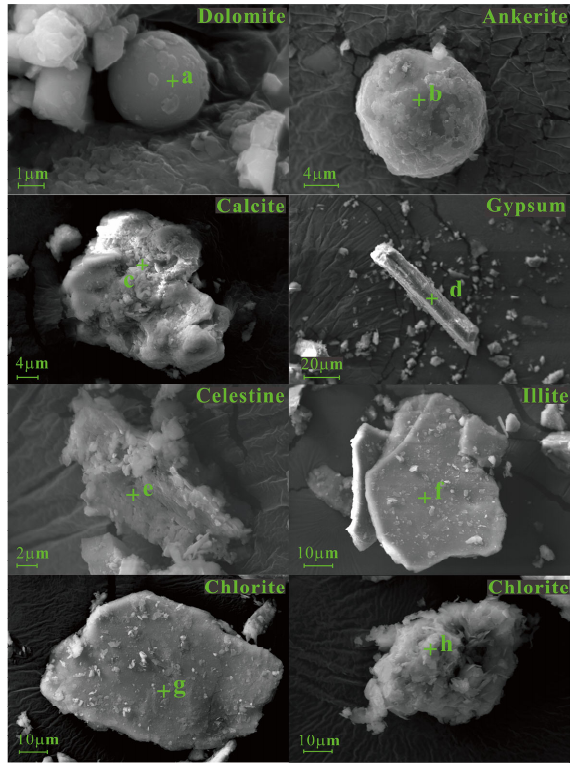
Figure 3. Microscopic morphology of carbonates, sulfates and clay minerals in drill core Ls2. Spheroidal dolomite ( a ) and ankerite ( b ), dense granular and flaked calcite ( c ), columnar gypsum granular ( d ), celestite aggregate ( e ), plate ‐ shaped illite ( f ) and chlorite ( g ), and flower ‐ like chlorite ( h ).